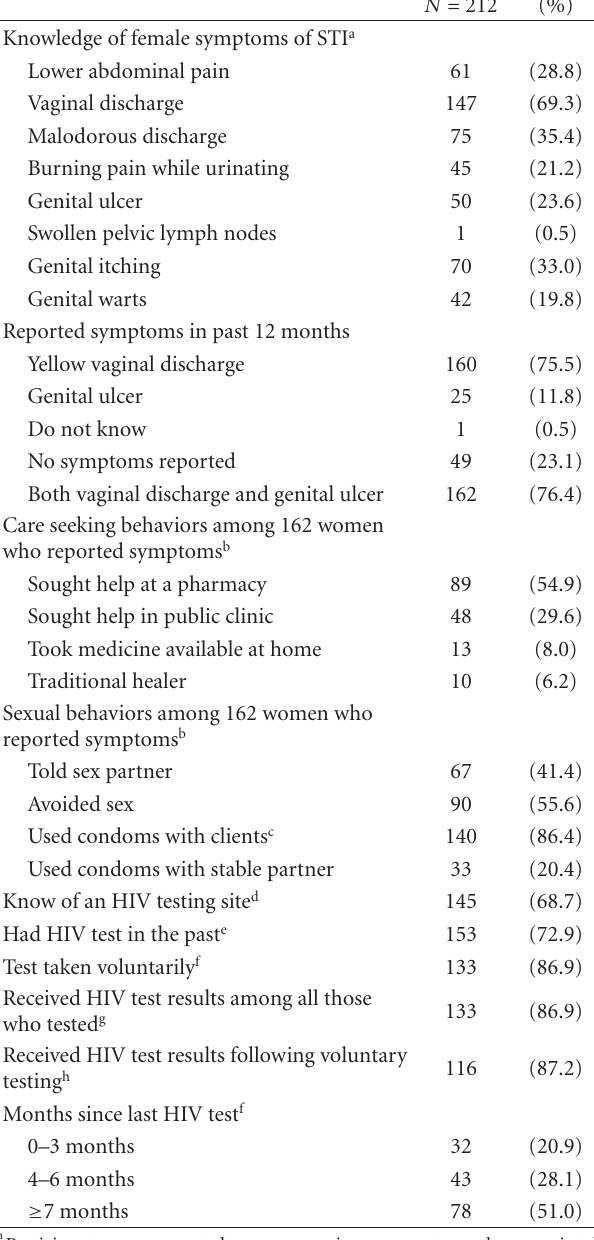
Table 3: Knowledge of STI symptoms, self-reported symptoms, and response to symptoms; HIV testing history and treatment-seeking behaviors among 212 clandestine female sex workers: Lima, Peru,